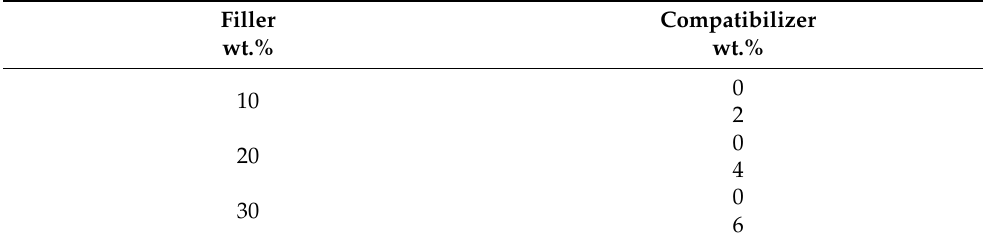
Table 3. Formulation of the in-house produced compounds.